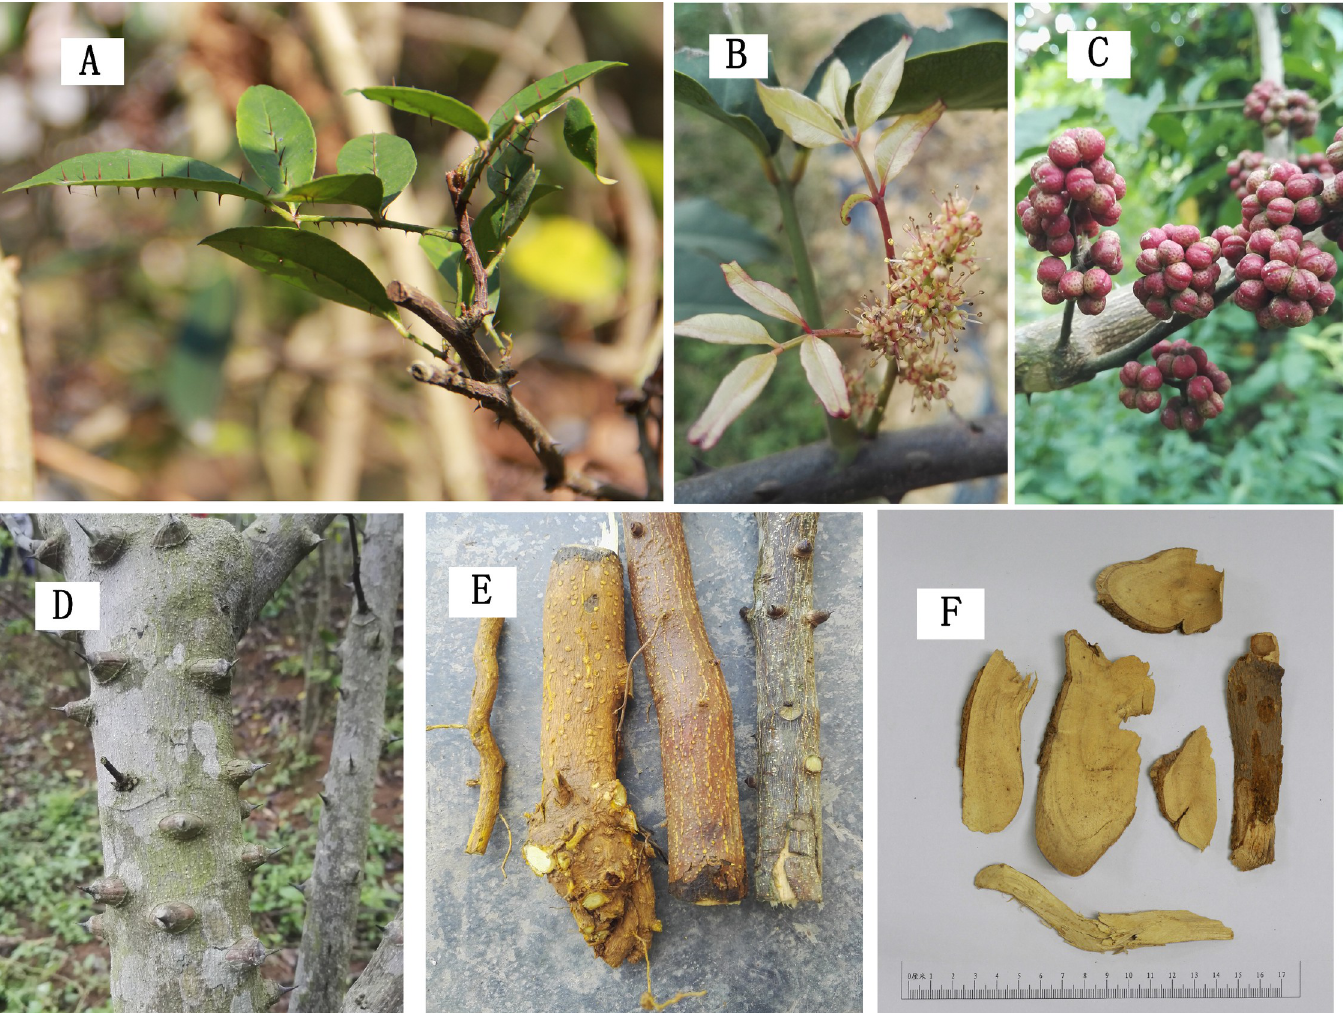
Fig 1. Morphology of Zanthoxylum nitidum . A. Opposite leaflet blades, two sides of leaves with prickles; B. Flowers 4-merous, perianth in 2 series; C. Fruit pedicel 2–5 mm, reddish-brown follicles; D. Nail-like, prickly stem; E. The branch root, main root, and the part connecting the root and stem from left to right; F. Slices of dried roots of Z . nitidum